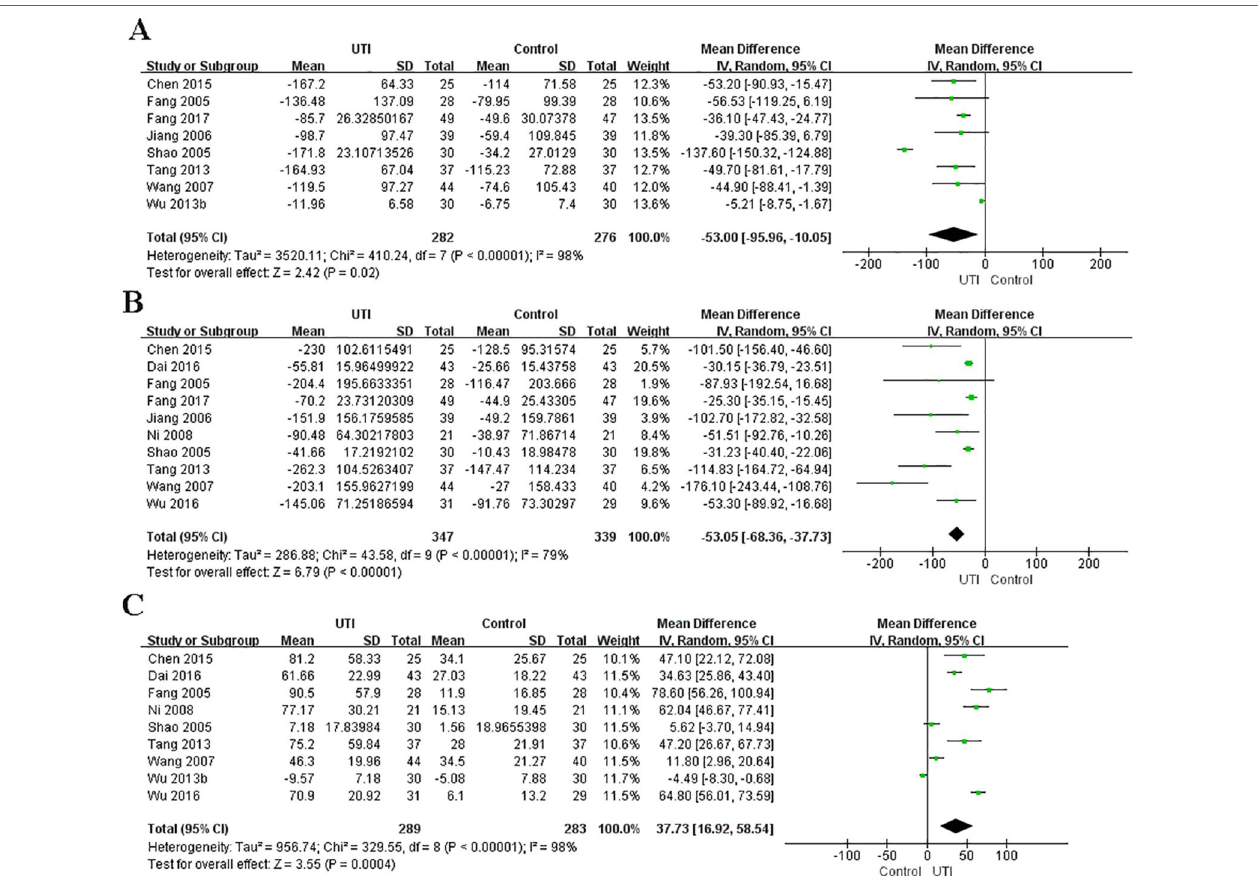
FIGURe 3 | Ulinastatin regulates the levels of pro-inflammatory and anti-inflammatory cytokines. Pro-inflammatory factor: IL-6 (A) , TNF-α (B) . Anti- inflammatory factors: IL-10 (C) .